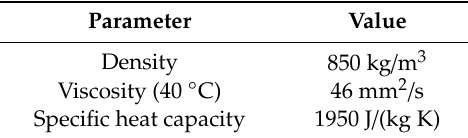
Table 1. Fluid properties.